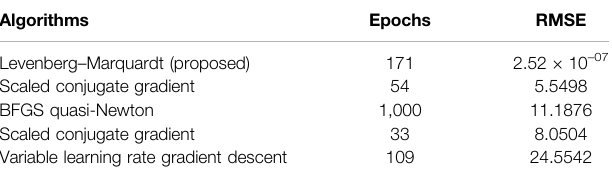
TABLE 8 | RMSE comparison.